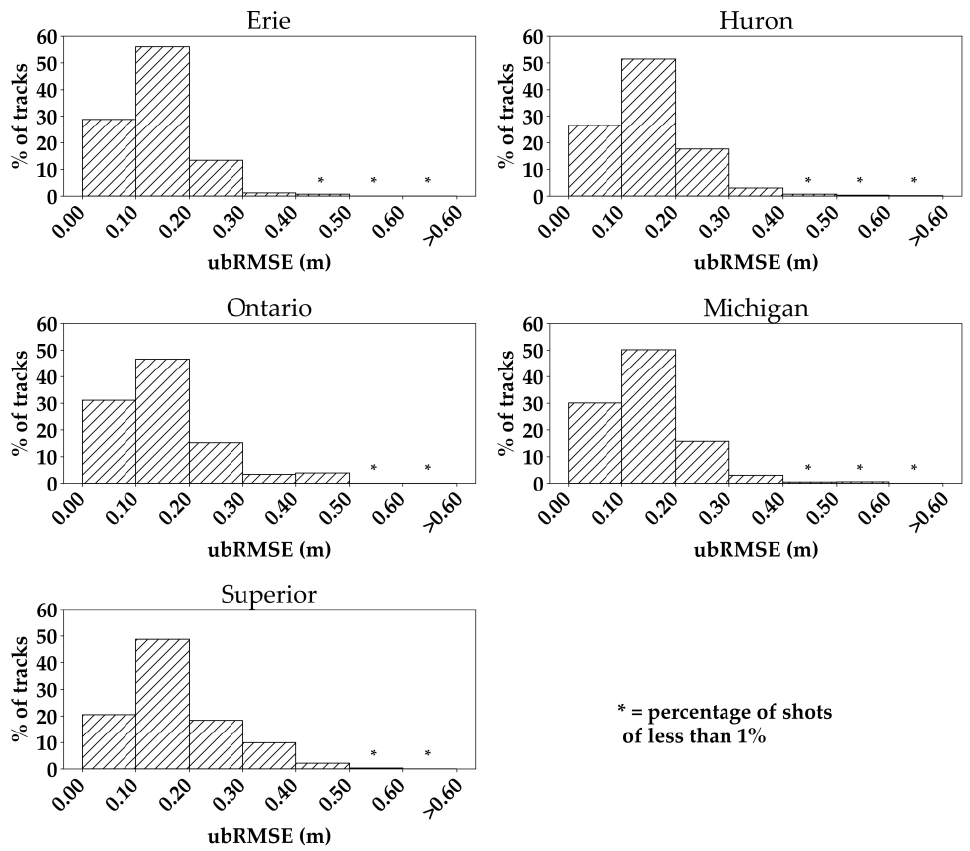
Figure 5. Distribution of the unbiased root mean squared error (ubRMSE) between GEDI shots and in situ elevations across the five studied lakes. The distribution corresponds to the ubRMSE of GEDI tracks (i.e., shots acquired on the same date with the same beam).